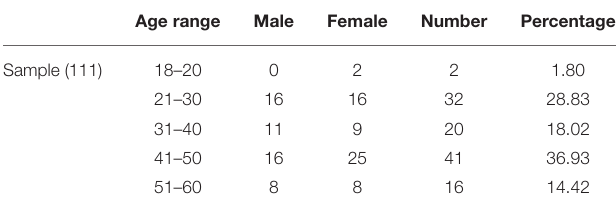
TABLE 1 | The descriptive statistics for the demographic characteristics of